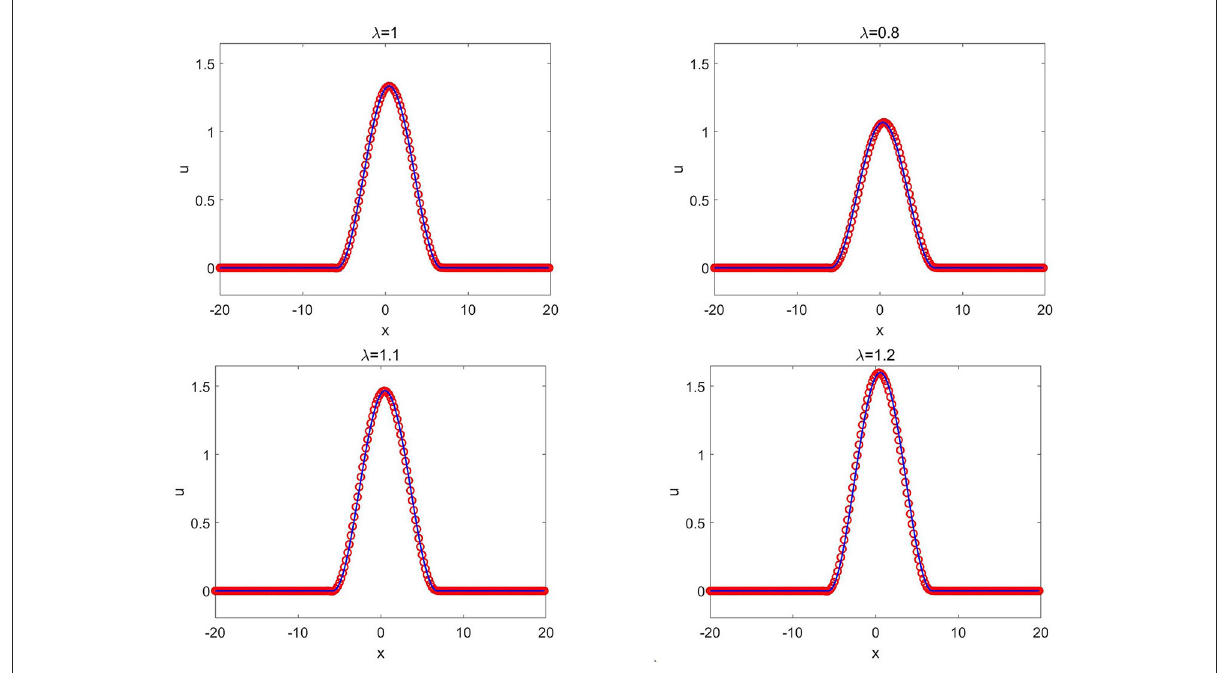
FIGURE4 K (2,2) equation in Example 3.3: the CANN solution (red circles) and the exact solution (solid blue lines) at T